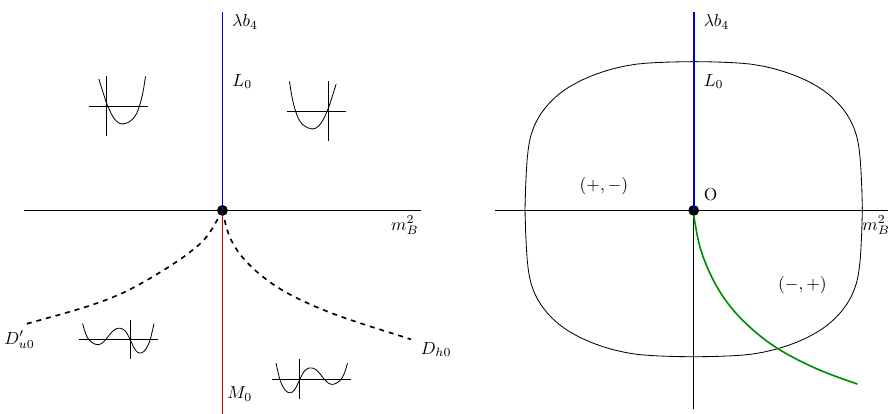
Figure 5. The m F = 0 section of the paraboloids in (4.8) is given in (cid:12)gure (a). The inset plots are the pro(cid:12)les of the LG potential (4.7) with the horizontal axis being the (cid:27) axis and the vertical axis being the value of the potential. Across the blue line the minimum of the potential passes through (cid:27) = 0. Along the red line a local maximum of the LG potential passes through (cid:27) = 0. The dashed lines correspond to either the appearance or disappearance of new extrema in the potential. The phase structure is given in (cid:12)gure (b) with the blue line denoting a second order Higgsing phase transition and the green line denoting a numerically-determined (cid:12)rst order phase transition. The ellipse (eq. (4.9)) is the intersection of the two dimensional plane with the ellipsoid (4.5). The (cid:12)rst order line lies to the right of the diagram | as depicted in the (cid:12)gure above | when j (cid:21) j < 1 but 2 moves to the left of the (cid:12)gure for j (cid:21) j > 1 . It runs exactly down the negative (cid:21)b 4 axis at j (cid:21) j = 1 2 2